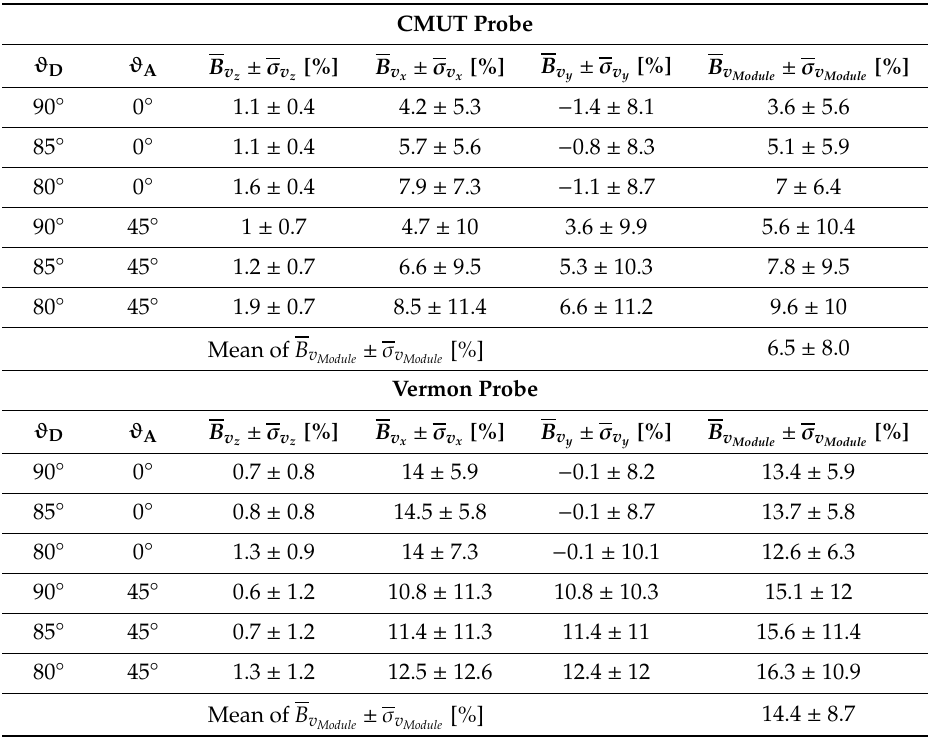
Table 2. Relative bias and mean standard deviation for